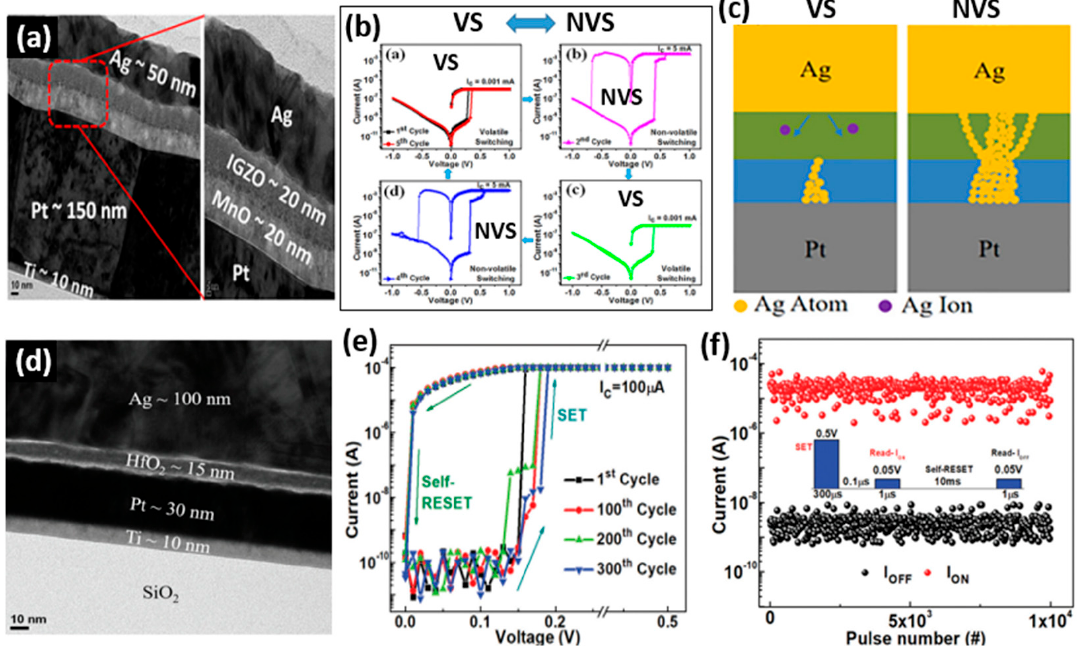
Figure 8. ( a ) The cross-sectional TEM image of a CBRRAM device with an IGZO/MnO bilayer switching medium. ( b ) The I-V characteristics of the bilayer device presenting a reversible transition between volatile switching and nonvolatile switching. ( c ) The schematic of the switching mecha- nisms during both volatile and nonvolatile switching. Reprinted from Ref. [57]. ( d ) The cross-sec- tional TEM image of an Ag/HfO 2 /Pt CBRRAM device. ( e ) The typical I-V characteristics of the Ag/HfO 2 /Pt device presenting highly uniform volatile TS and ( f ) its pulse endurance characteristics for the volatile TS. Reprinted from Ref. [17].